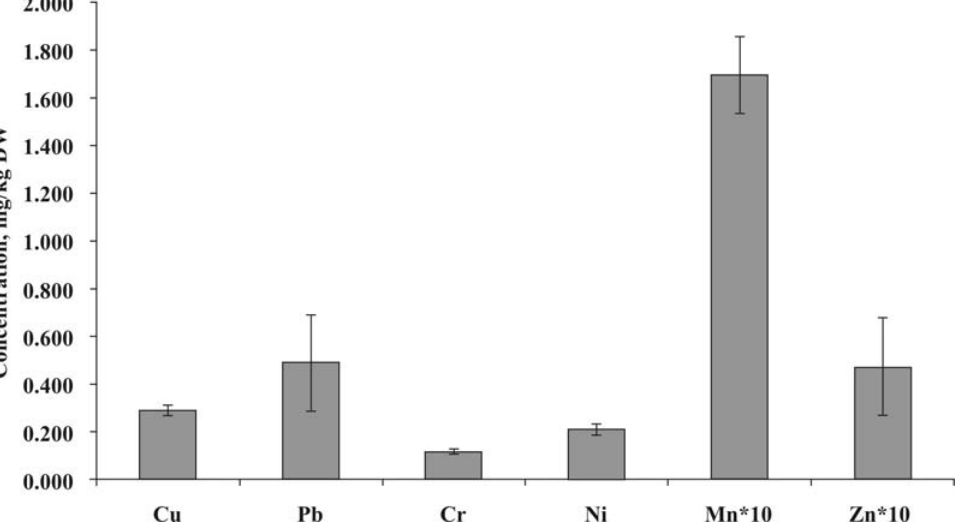
Fig. 6. Median data of metal concentrations in wood (mg/kg dry weight) (n =